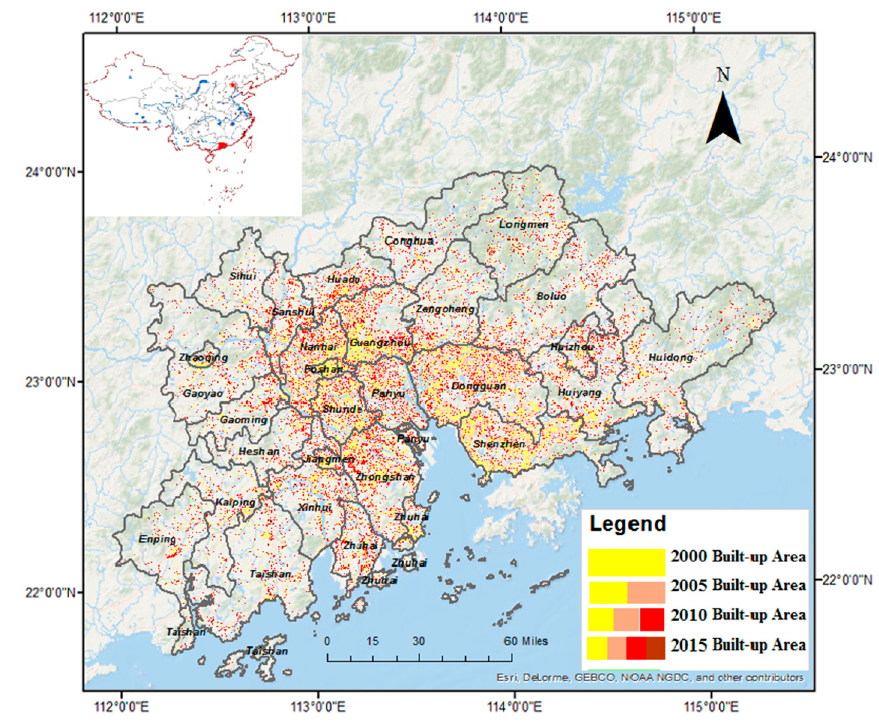
Figure 1. Study area: the Pearl River Delta (PRD) megaregion.